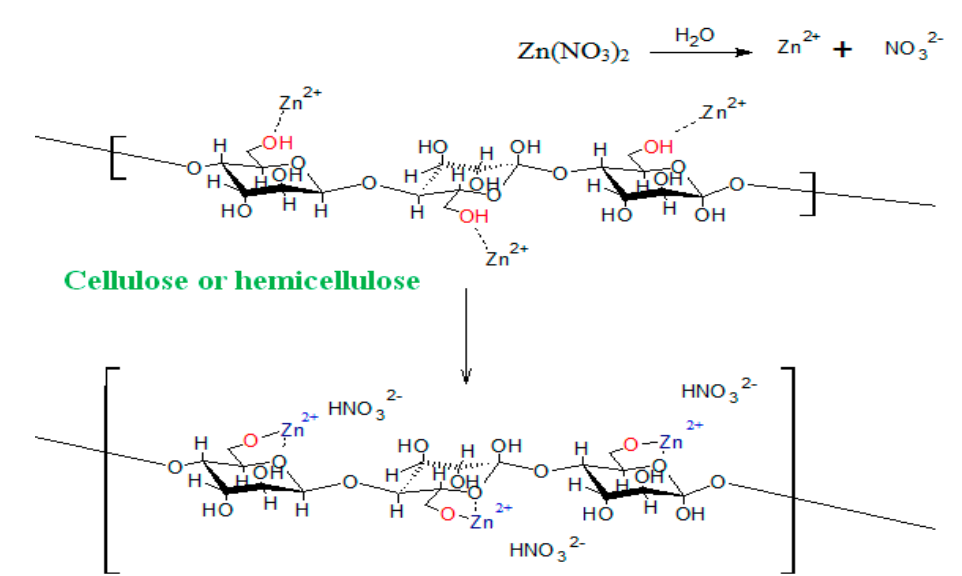
Figure 7. Possible pathway for the fixation of Zn 2+ onto the L.C surface.